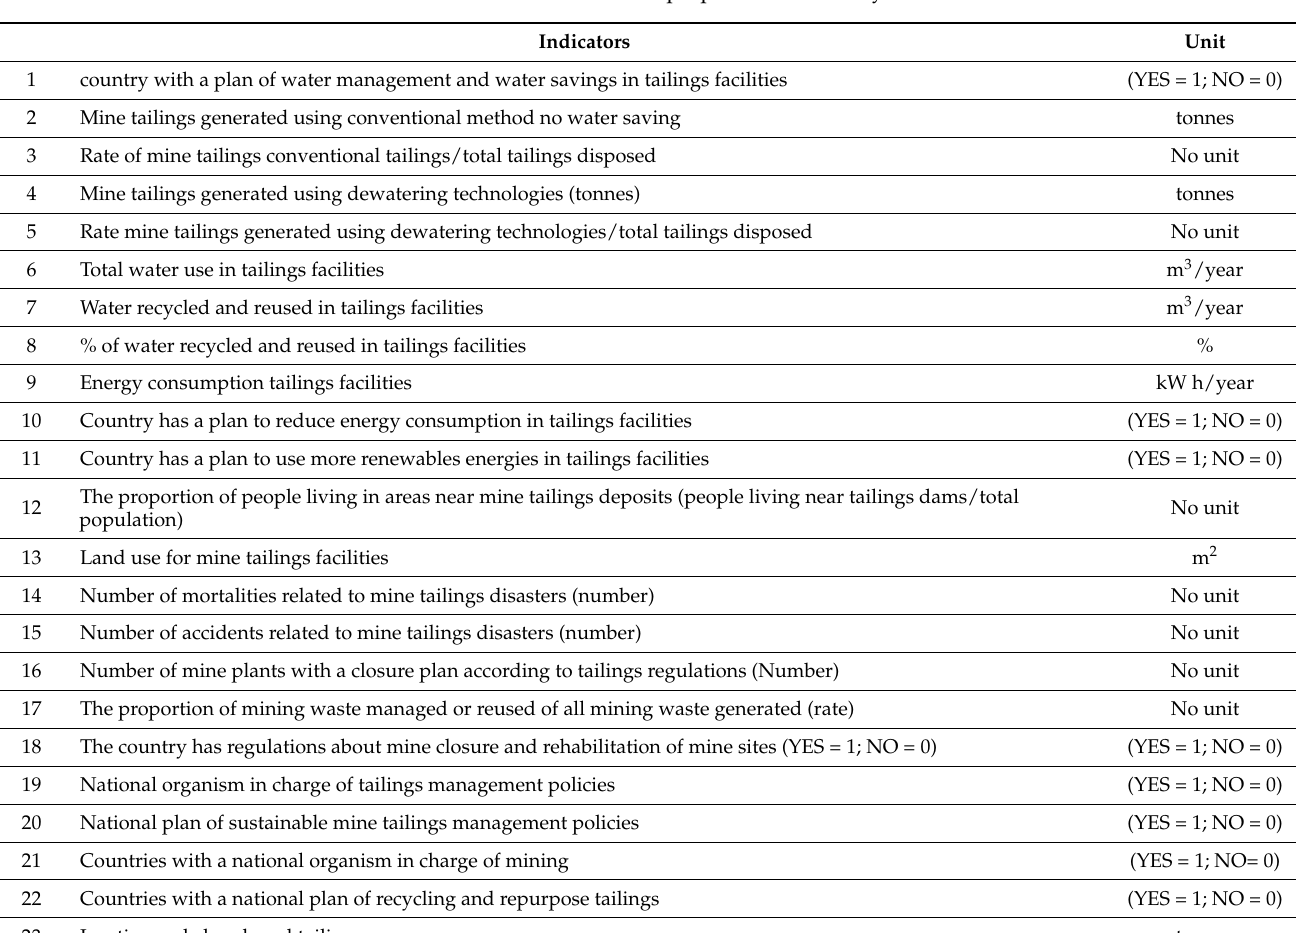
Table 2. Set of indicators proposed in the